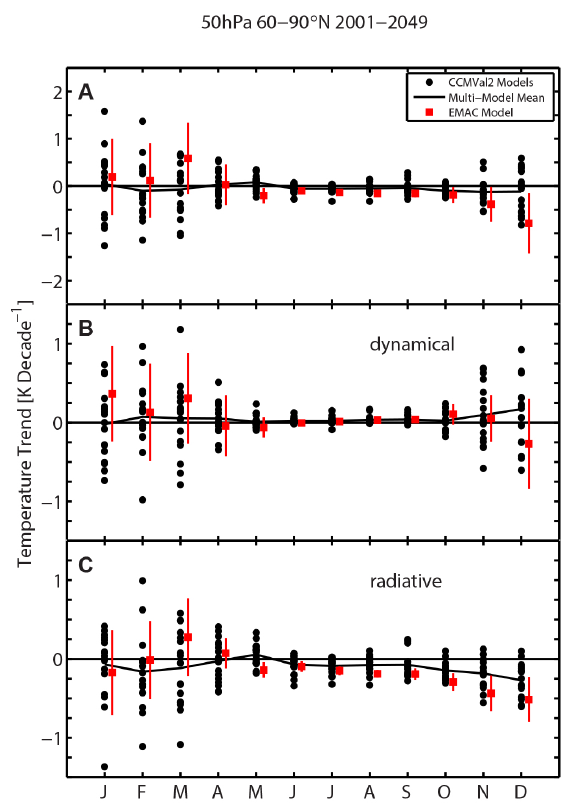
Fig. 6. Arctic temperature trends per decade at 50hPa for each month from EMAC (red) and CCMVal2 models (black) for the years 2001–2049. The figure shows the area-weighted average over 60–90 ◦ N. (A) Temperature trend. (B) Dynamical component of the trend. (C) Residual radiative component of the trend. Vertical bars show the 2 σ uncertainty. Note the different scale for (B) and (C) .